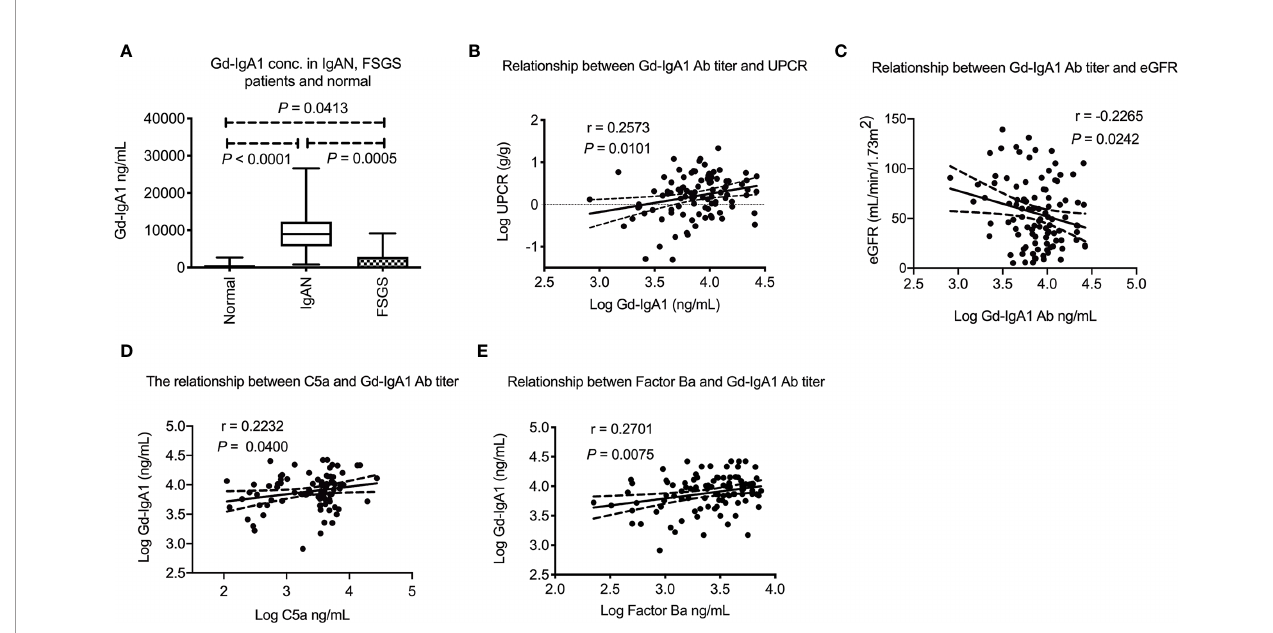
FIGURE 4 | Plasma Gd-IgA 1 level in IgA nephropathy patients and their relationship with plasma C5a and factor Ba. (A) Plasma Gd-IgA 1 concentration was signi fi cantly higher in IgAN patients than FSGS patients or healthy subjects ( P = 0.0005 and P < 0.0001, respectively). The Gd-IgA 1 level was only a litter higher in FSGS patients than normal subject ( P = 0.0413). (B) Plasma Gd-IgA 1 level was positively correlated with level of proteinuria ( P = 0.0101, r = 0.26). (C) Plasma Gd- IgA 1 level was negatively correlated with renal function ( P = 0.0242, r = -0.23). (D) Positive association between level of plasma C5a and Gd-IgA 1 ( P = 0.0400, r = 0.22). (E) Positive association between level of plasma factor Ba and Gd-IgA 1 ( P = 0.0075, r = 0.27). UPCR, urinary protein to creatinine ratio; eGFR, estimated glomerular fi ltration rate.